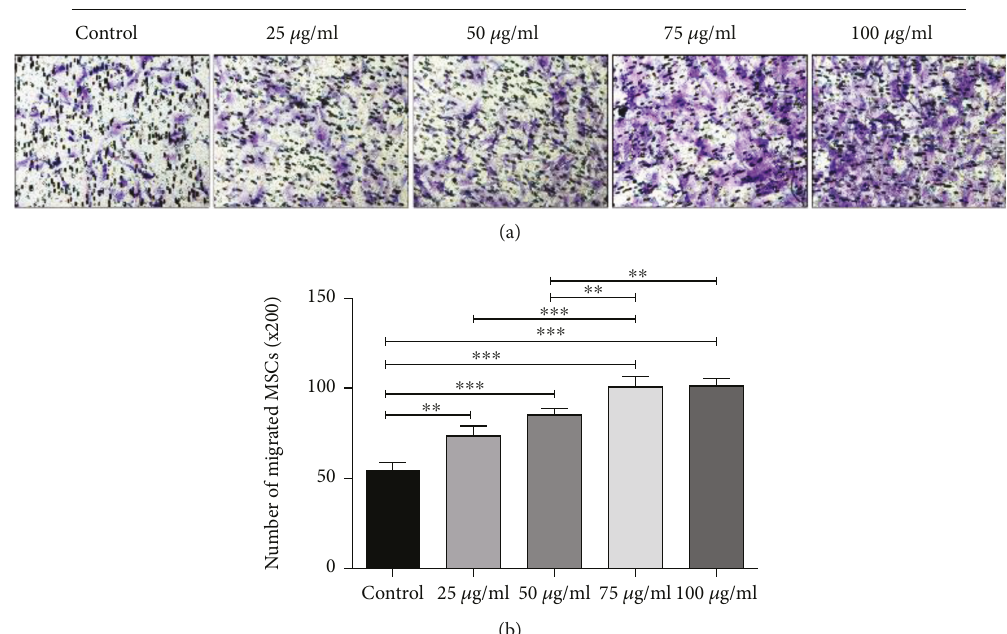
Figure 6: Transwell migration assay of MSCs. (a) Migration of MSCs treated with NPC exosomes at the concentration of 25 μ g/ml, 50 μ g/ml, 75 μ g/ml, and 100 μ g/ml was observed under the microscope (x200). (b) Numbers of migrated MSCs at the concentration of 25 μ g/ml, 50 μ g/ml, 75 μ g/ml, and 100 μ g/ml. All data were showed as mean ± SD . N = 3 . ∗ P < 0 05 , ∗∗ P < 0 01 , and ∗∗∗ P < 0 001